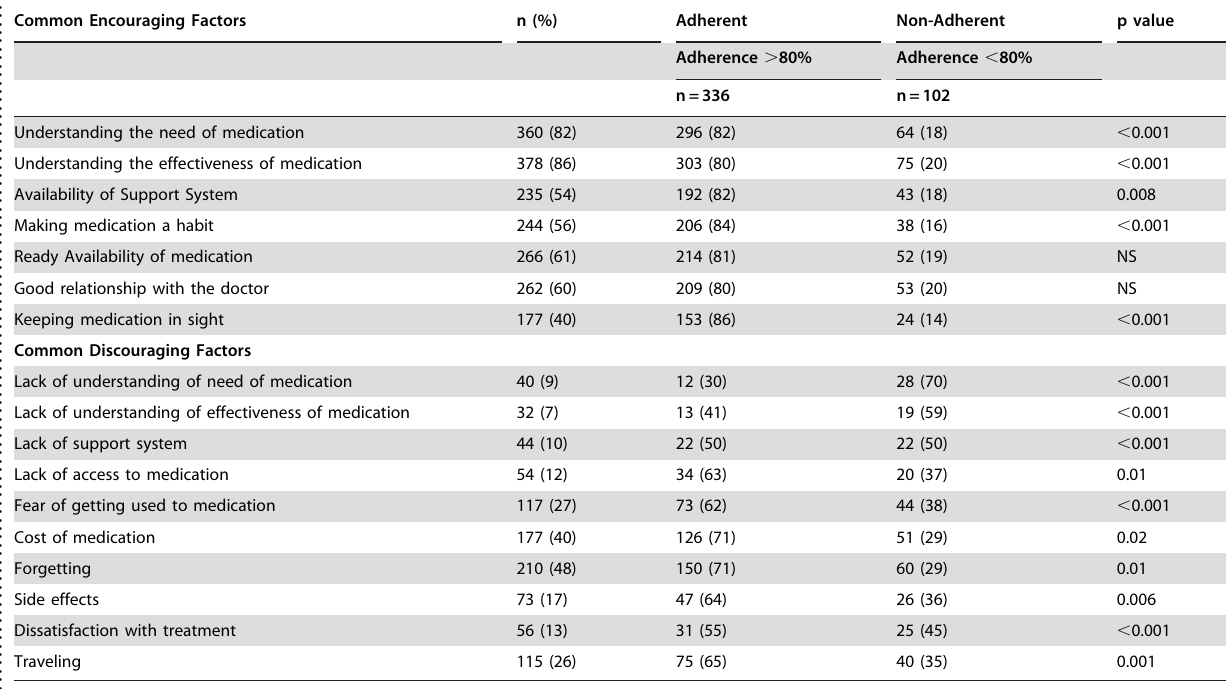
Table 5. Factors that, in the patient’s views, encouraged or discouraged the patient’s drug taking behavior .. ... .... ... ... .... ... ... .... ... ... .... ... ... .... ... ... .... ... ... .... ... ... .... ... ... .... ... ... .... ... ... .... ... ... .... ... ... .... ... ... .... ... ... . Common Encouraging